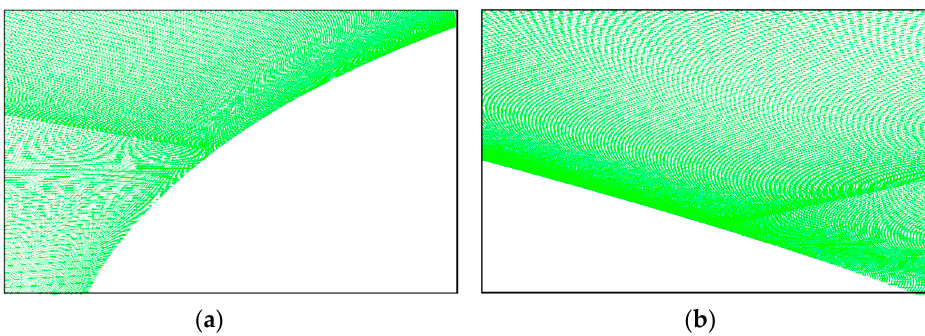
Figure 3. Generated mesh for the CFD solution near the wall of the airfoil (268,107 cells) ( a ) near the upper leading-edge wall, ( b ) near the upper trailing edge wall.